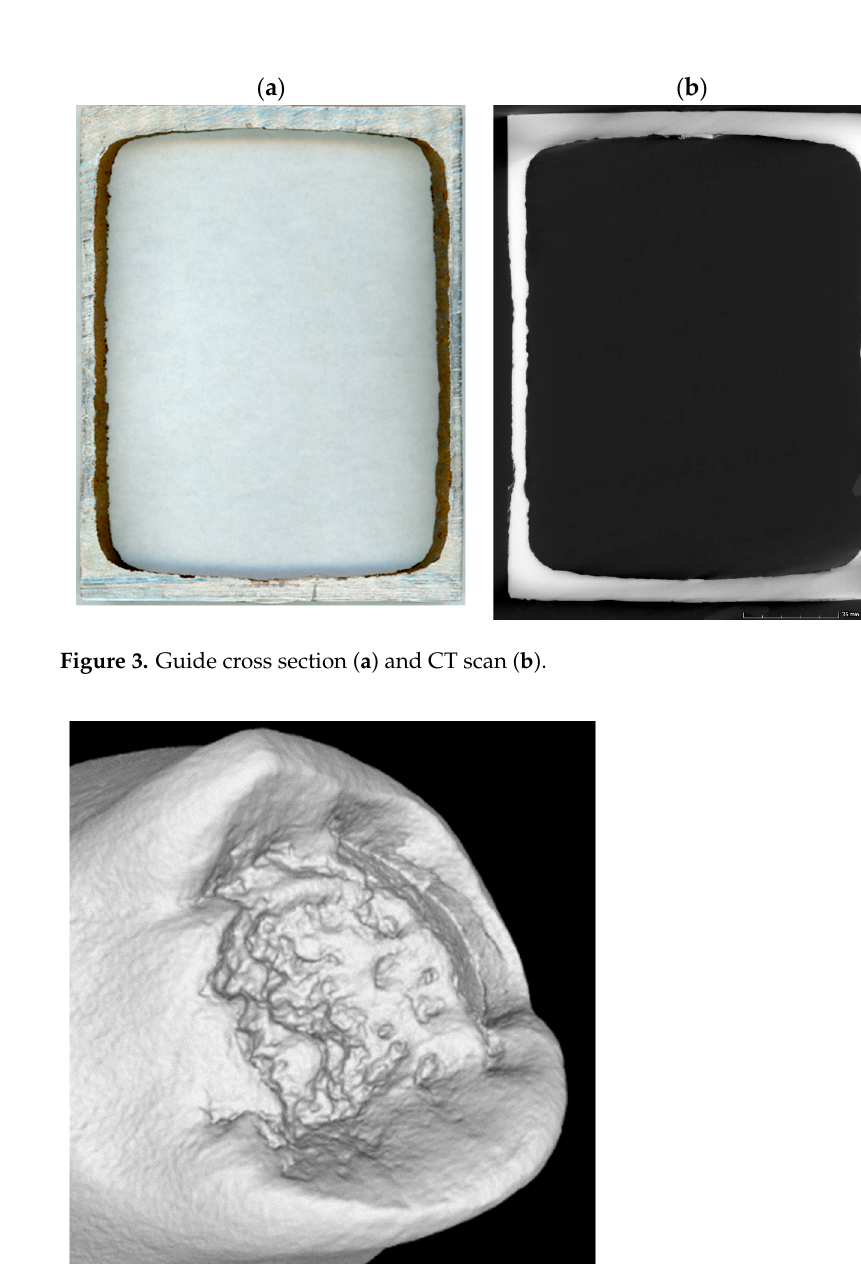
Figure 4. Sample after tensile test CT